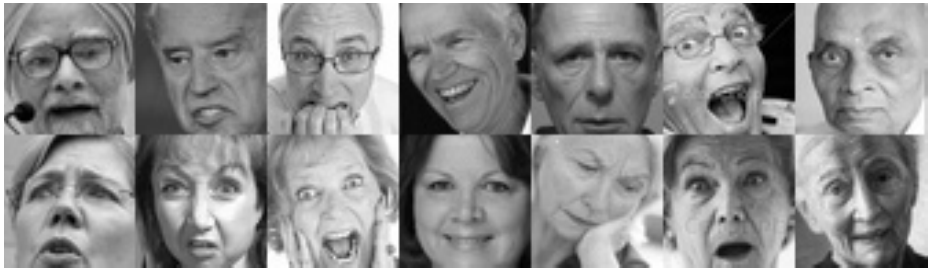
Figure 20. Sample images of human facial expressions of elderly man and woman in the FER-2013 dataset.